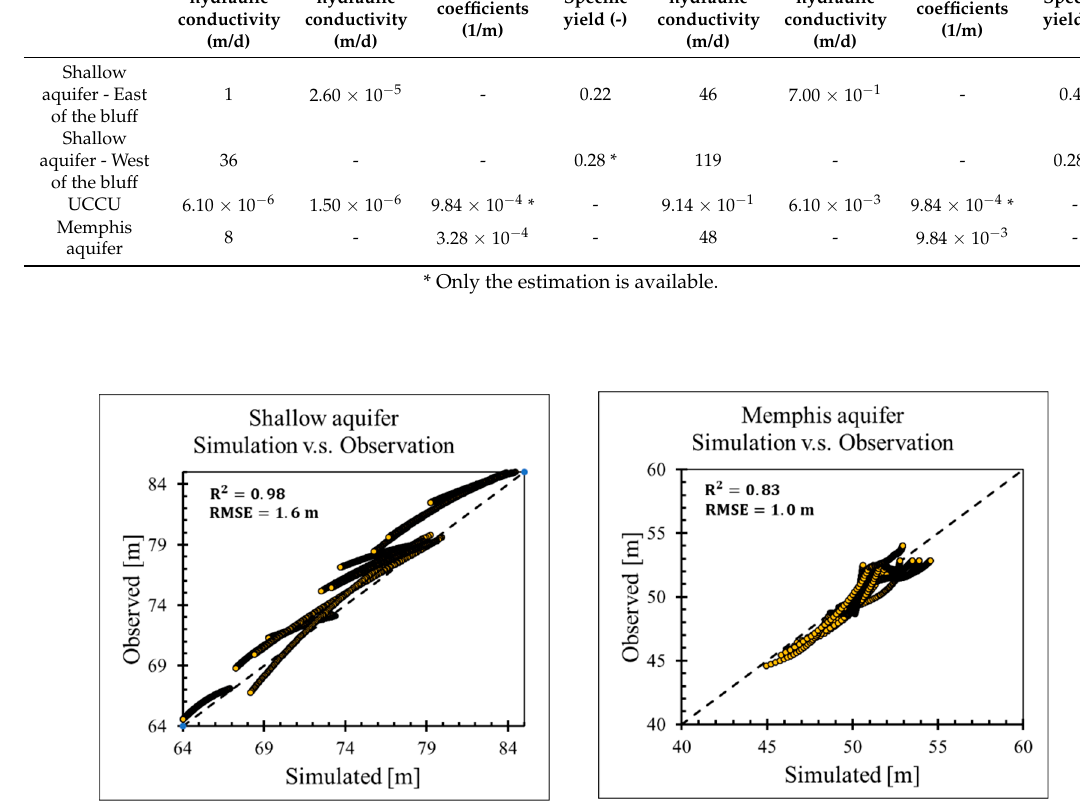
Figure 7. ( a , b ) show observed vs simulated results of the model for the Shallow and Memphis aquifers,